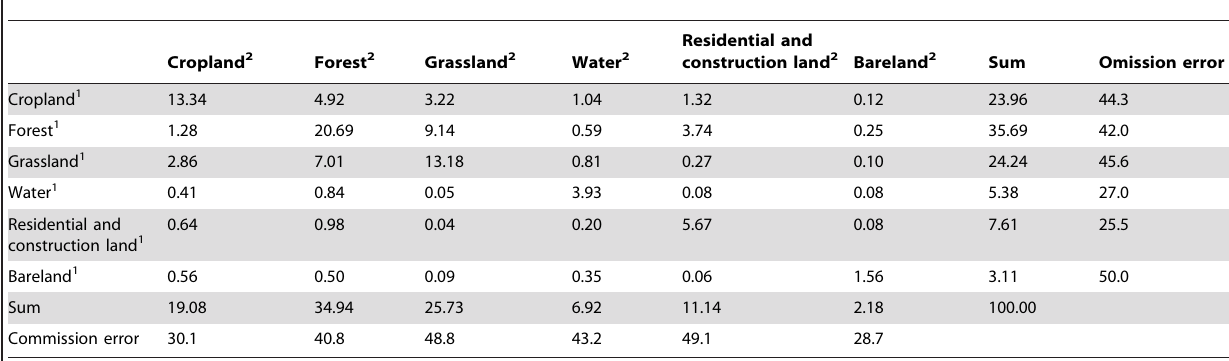
Table 6. Error matrix of common classification approach (Maximum Likelihood Approach).